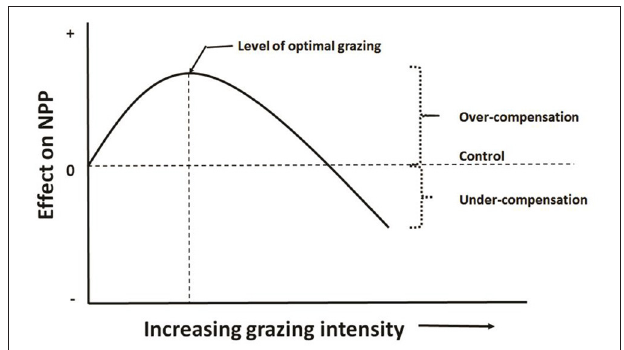
FIGURE 2 | Herbivore-optimization curve (redrawn from McNaughton, 1983) showing level of optimal grazing occurs in mid grazing intensity, which can be defined as number of herbivores, their biomass, or the amount of tissue